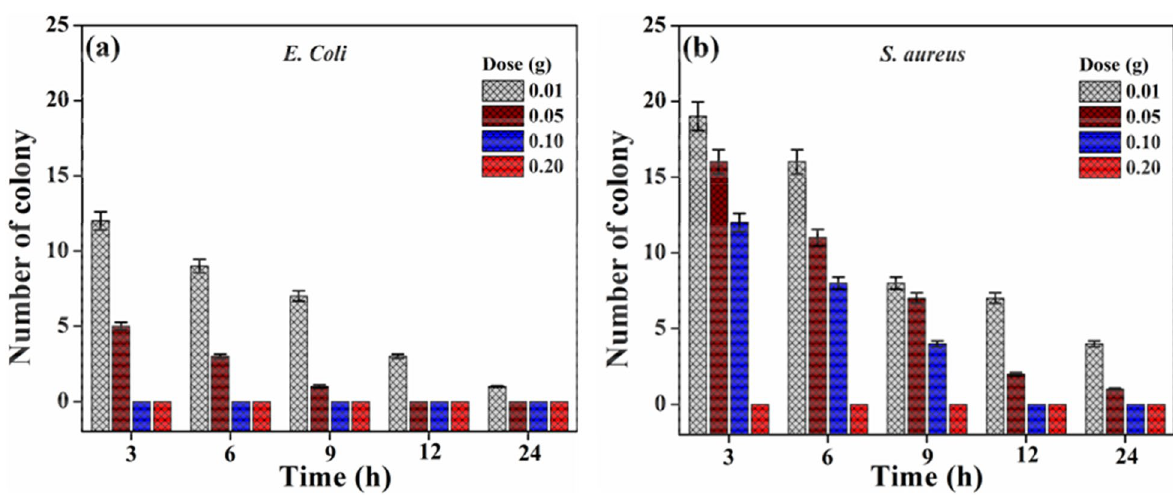
Figure 10. Antibacterial activity of PMC materials against ( a ) E. Coli , and ( b ) S.